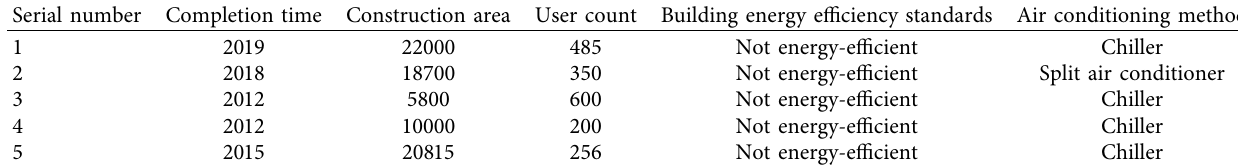
Table 1: Basic information on commercial office buildings.